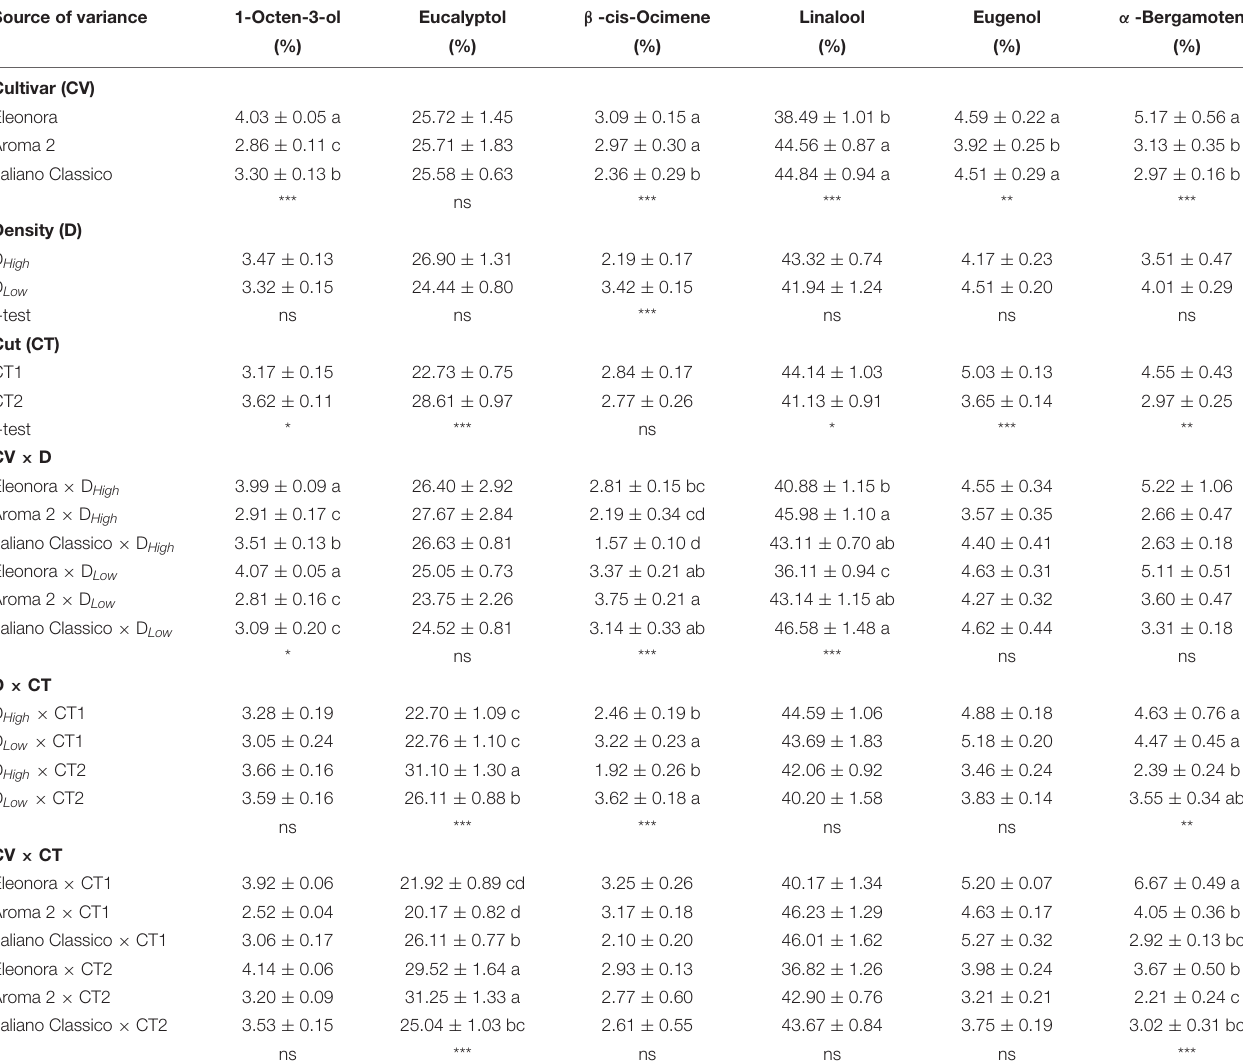
TABLE 6 | Most abundant volatile compounds of Genovese basil cultivars Eleonora, Aroma 2, and Italiano Classico in light of density and cut treatments. Source of